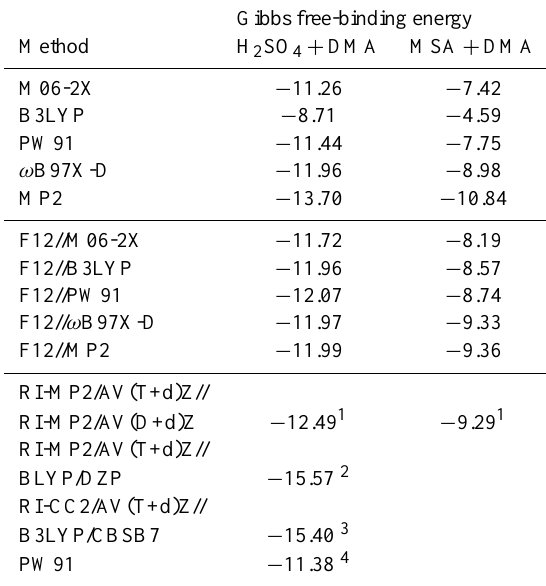
Table 1. Comparison of various computational approaches for cal- culating Gibbs free-binding energies. Unless otherwise stated, the basis set is 6-311++G(3df,3pd). F12 is shorthand for CCSD(T)- F12/VDZ-F12. Values in kcalmol − 1 . Gibbs free-binding